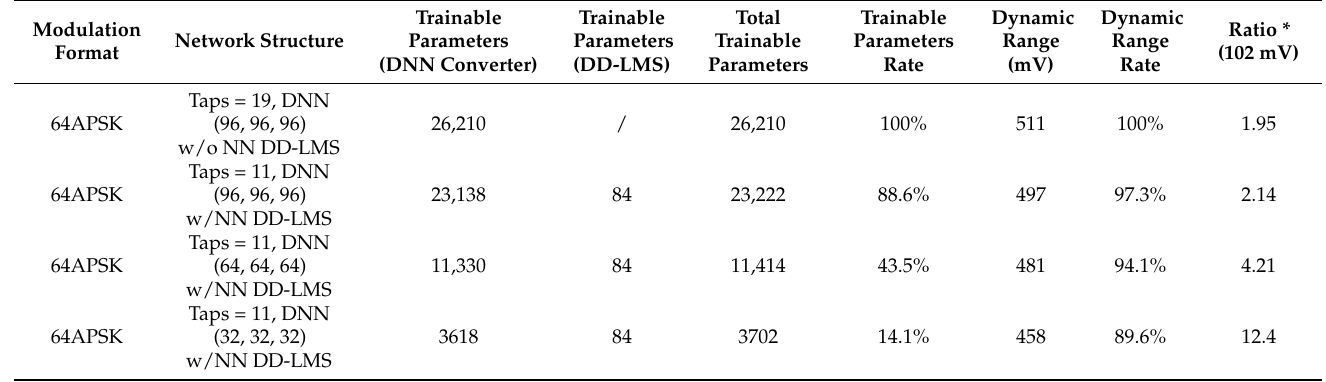
Table 1. Comparison of different receivers in 64APSK UVLC system.